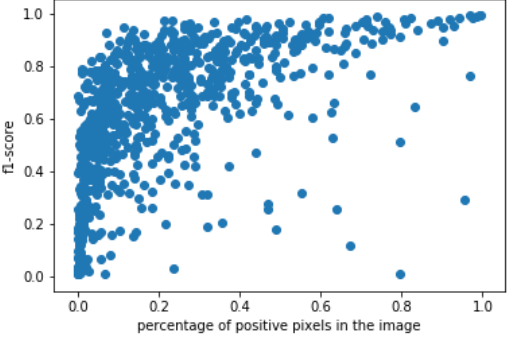
Figure 7. f1-score vs percentage of corroded pixels Figure 8 shows the results from another perspective. It presents the percentage of corroded pixels per connected component in the reference image. The horizontal axis represents the average area per corrosion spot, i.e., the percentage of corroded pixels divided by the number of connected components on the image label. The vertical axis shows the performance metric, either the f1-score or IoU. The color scale refers to the percentage of positive ( corroded ) samples over the whole image. One infers from Figure 8 that the average area of corroded spots more than the image-wise percentage of corroded pixels is determinant of networks performance. Samples 1 and 2 of figure 6 (lower row) show examples of good outcomes produced by DeepLab v3+. They correspond to points 1 and 2 in the plots of figure 8. Even not belonging to the group with a sizeable corroded percentage (less than 30%), these images have large average areas per corrosion area, which Table 2. Overall performance on 2D images. places them at the right side of the plots in figure